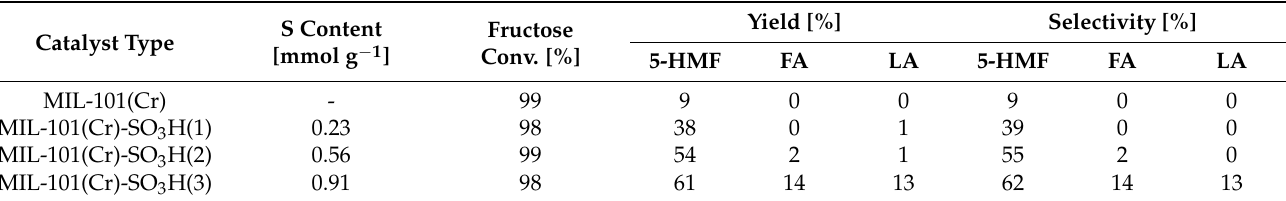
Table 1. Effect of different -SO 3 H loadings on MIL-101(Cr) in terms of 5-HMF yield. Reaction